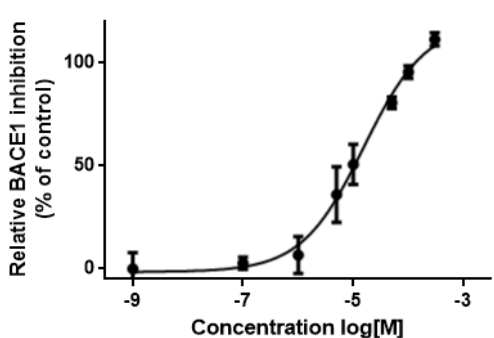
Figure 8. BACE1 inhibitory profile of the most promising hit-compound 11 . Each data point expresses the percentage of BACE1 activity inhibition and represents the mean ± SD of at least three independent experiments performed in triplicate (the control is the enzyme activity determined in the absence of inhibitors).